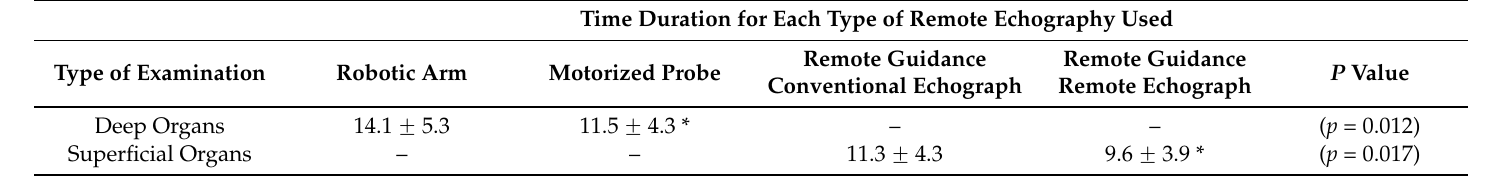
Table 2. Duration of examination for each category of organ and each method of remote echography. Time Duration for Each Type of Remote Echography